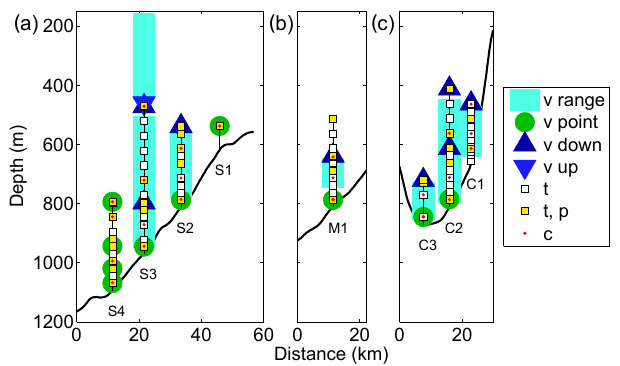
Figure 2. Mooring arrays: (a) section S, (b) mooring M1, and (c) section C. Each section is viewed looking downstream (south- ernmost mooring on the left). Sensors for temperature, pressure, conductivity, point velocity, as well as the range covered by the upward- and downward-oriented acoustic velocity profilers, are in-